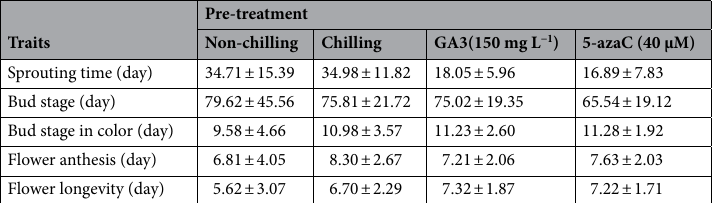
Table 2. Mean values ± SD for measured phenological traits under different pre-treatment conditions in 18 studied accessions of Anemone .